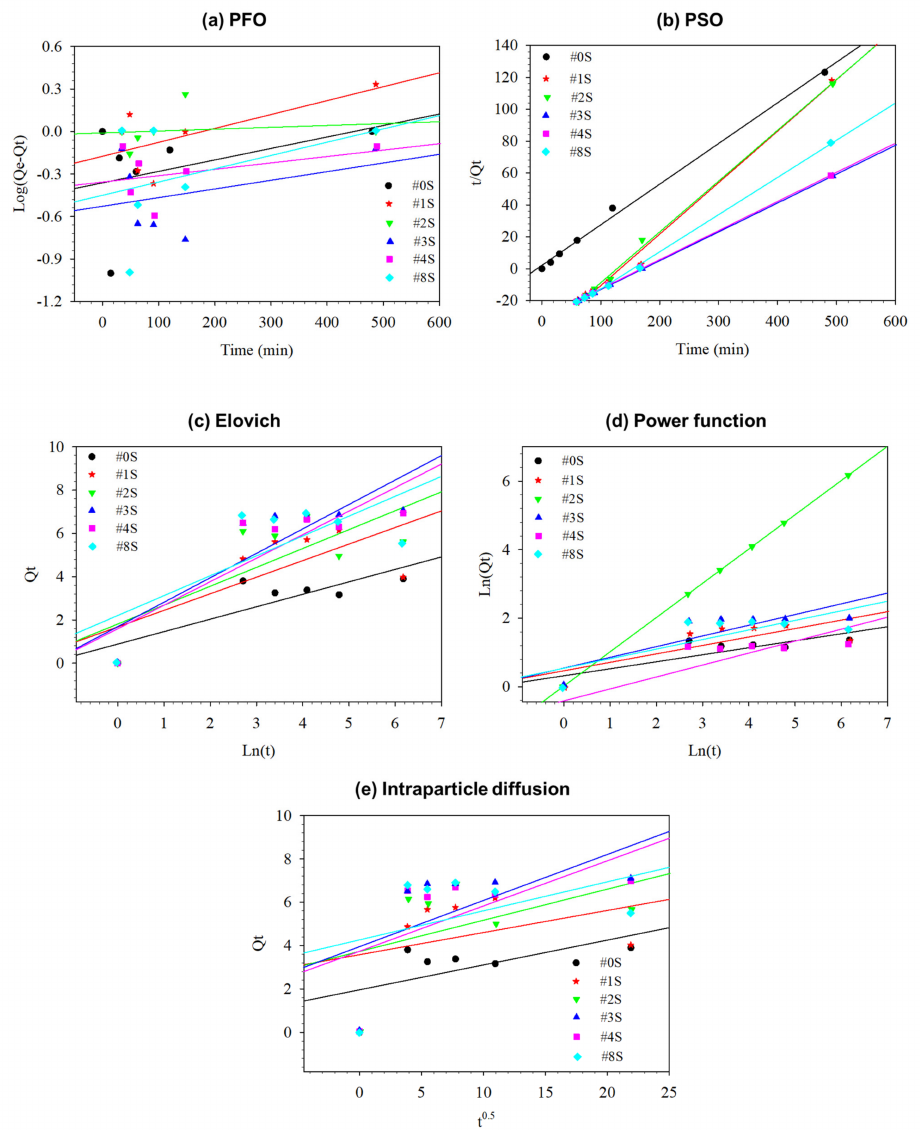
Figure 7. Plot lines showing the kinetic models for ( a ) PFO, ( b ) PSO, ( c ) Elovich, ( d ) Power function, and ( e ) Intraparticle